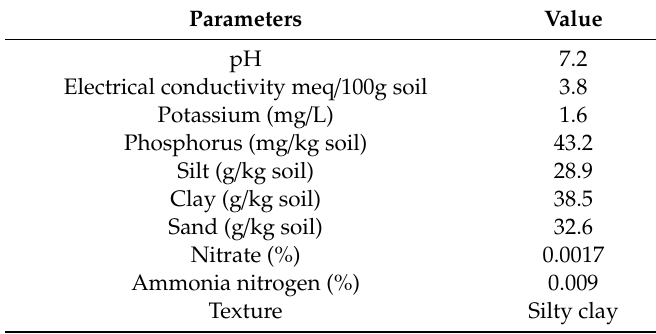
Table 1. Initial physical and chemical properties of the experimental